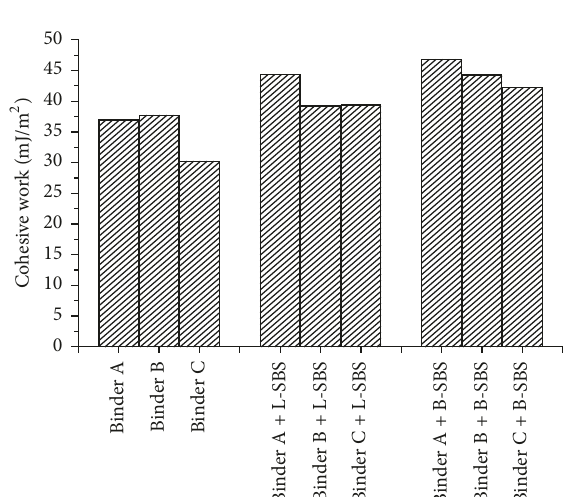
Figure 5: Plot of 𝛾 𝑙 versus 𝛾 𝑙 cos 𝜃 .